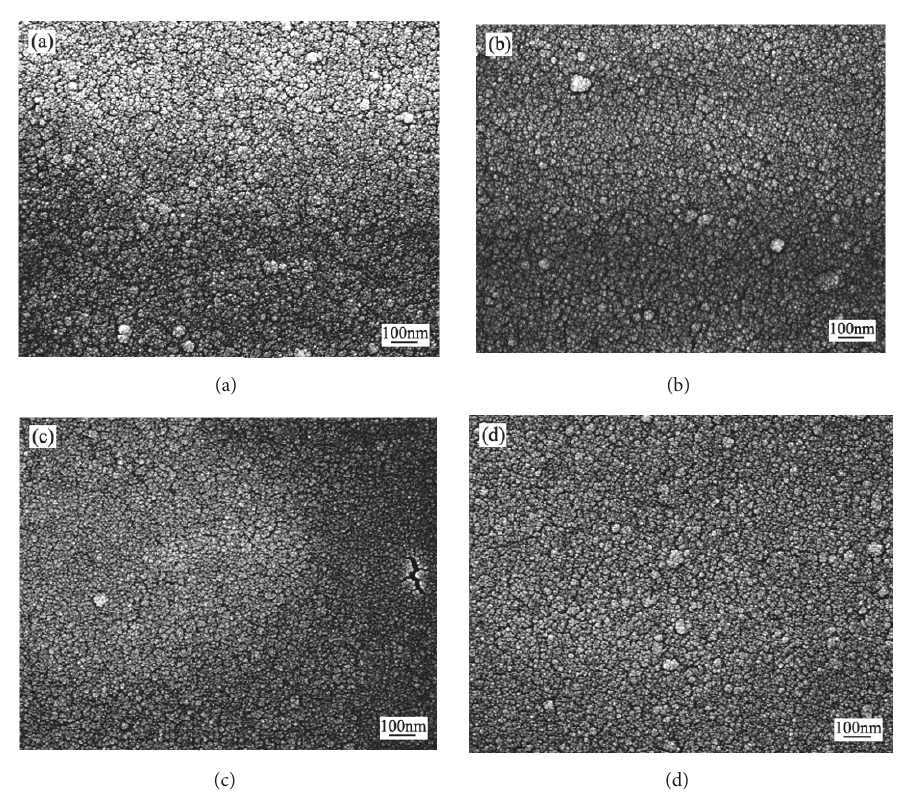
Figure 2: SEM micrograph under different current densities: (a) 20 A/dm 2 ; (b)30 A/dm 2 ; (c) 40 A/dm 2 ; (d) 50A/dm 2 .